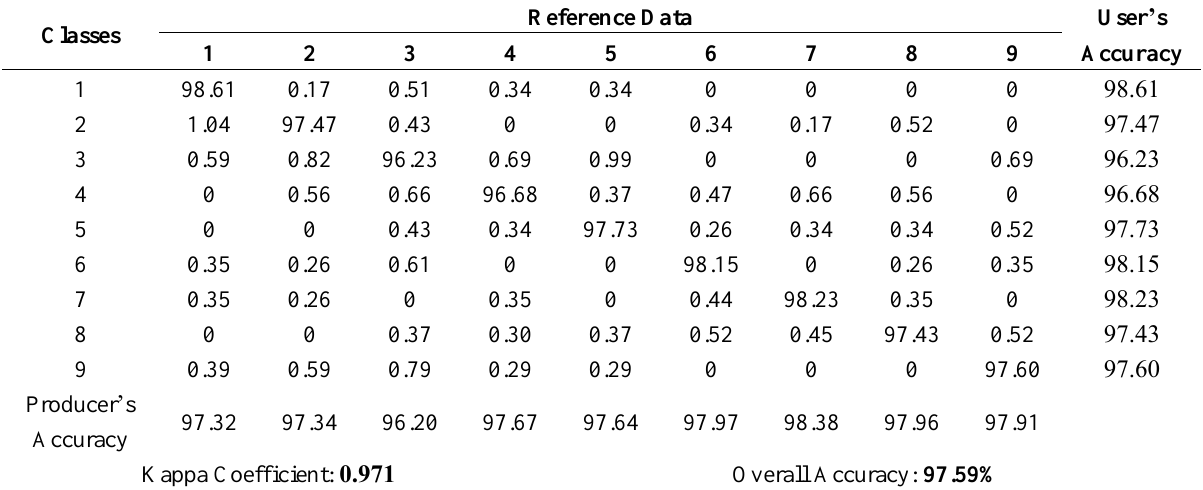
Table 5. The classification error matrix for data set Pavia City Center (in percentage).